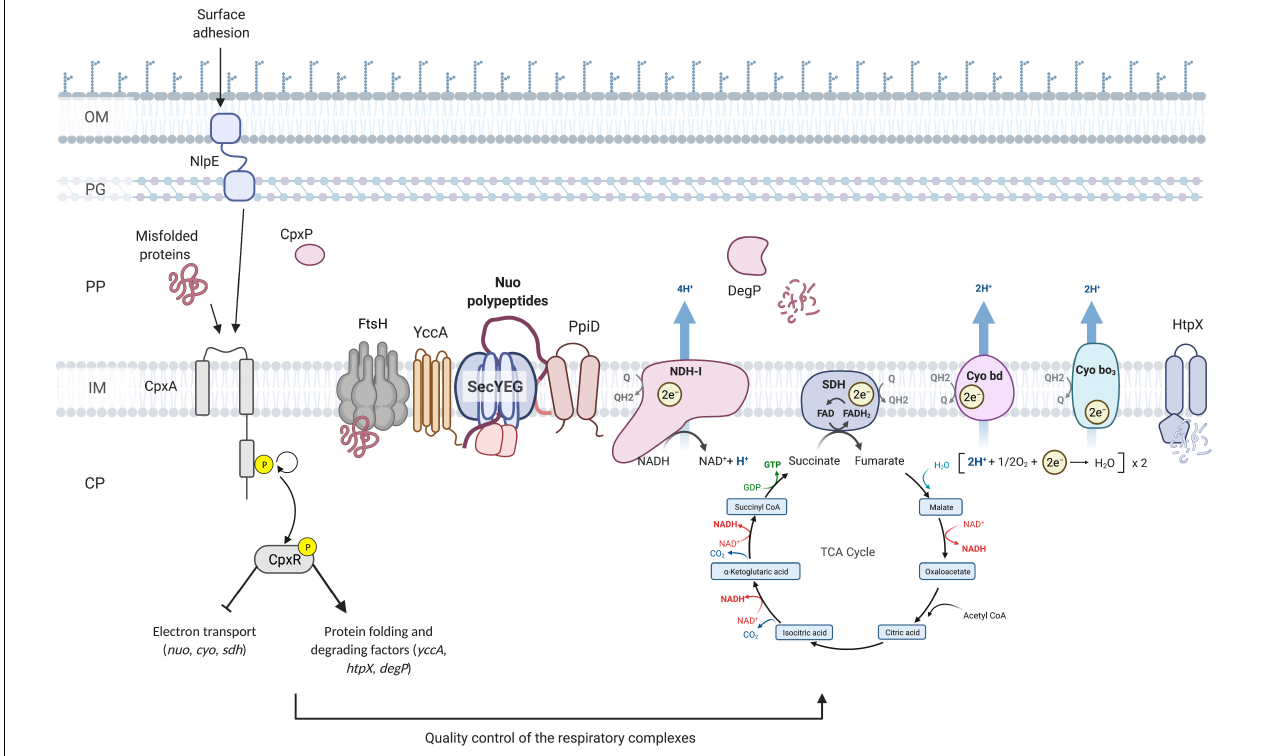
FIGURE 7 | Model of the quality control of the ETC performed by the Cpx envelope stress response at the inner membrane of E . coli . Upon activation of the Cpx response, CpxR represses the transcription of the operons encoding the NDH-I ( nuo ), cytochrome bo 3 ( cyo ) and succinate dehydrogenase ( sdh ) respiratory complexes. In addition, the Cpx response regulates the biogenesis of these complexes beyond transcription through increased expression of protein folding and degrading factors. Cpx-regulated protein folding factors assist with the secretion and further insertion of integral parts of the ETC complexes, whereas the proteolytic factors maintain the adequate turnover and degradation of the misfolded or mislocalized proteins. OM, outer membrane; PG, peptidoglycan; PP, periplasm; CP, cytoplasm; Q, quinone; Cyo, cytochrome.